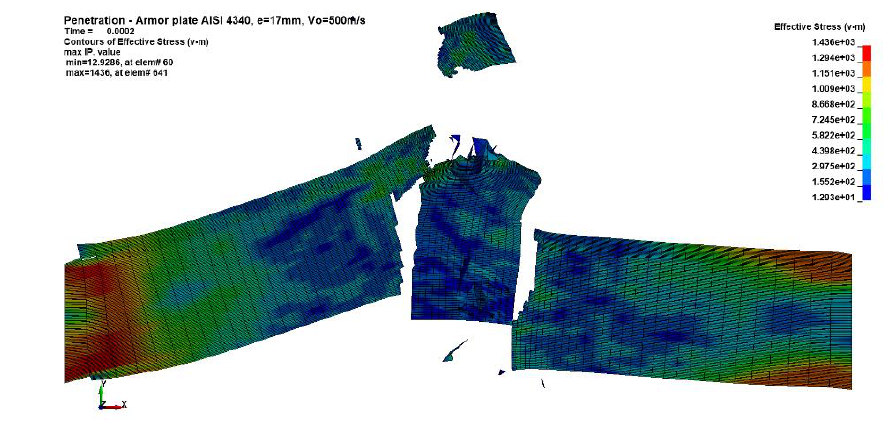
Figure 21– Von Misses equivalent stress, time of analysis 0.2 ms – Model 3 Рис. 21 – Von Misses эквивалентное напряжение, время анализа 0.2 ms – Модель